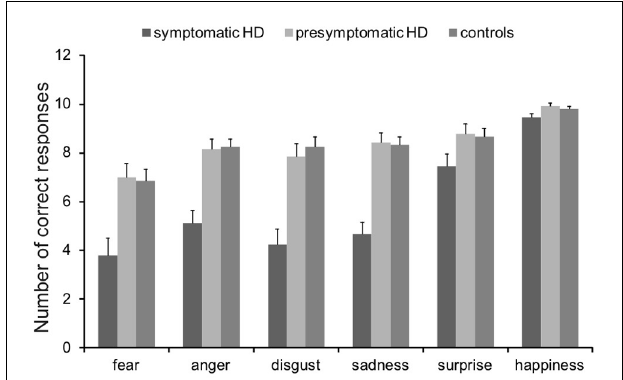
FIGURE 2 | Number of correct answers on the FEEST (SE), separated for Group and as a function of Emotion.